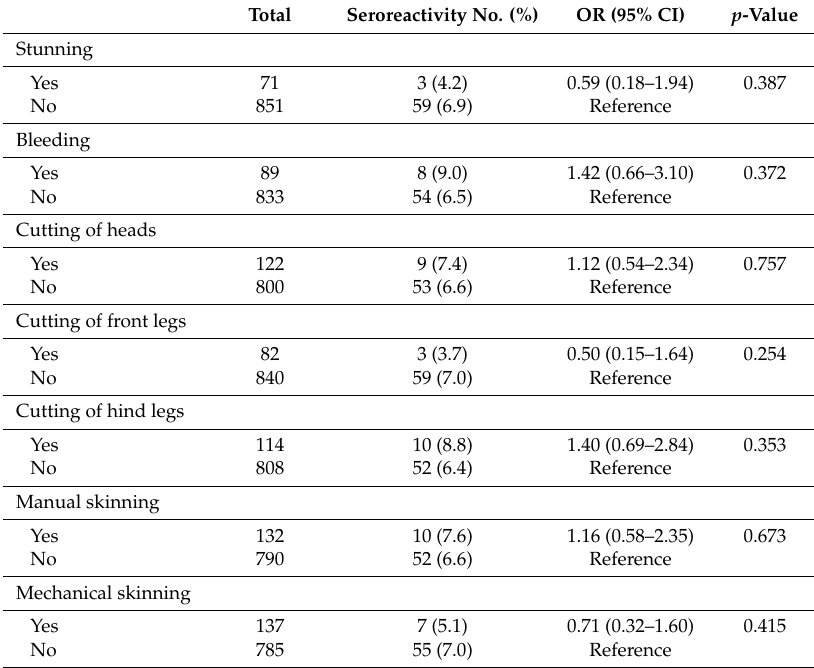
Table 2. Univariate logistic regression analysis of the association between specific work activities and brucellosis seroreactivity among cattle slaughterhouse workers in South